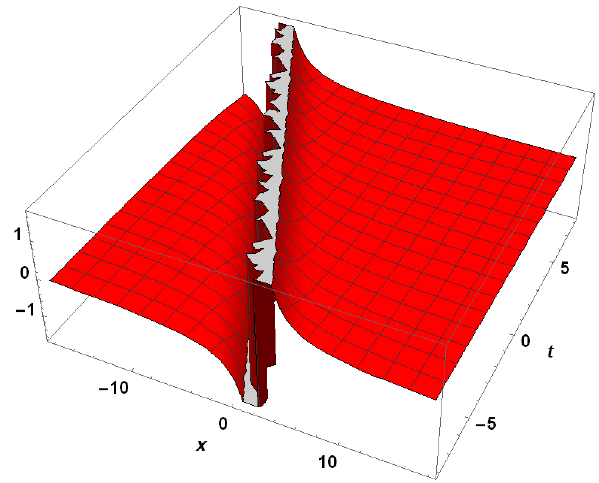
Figure 5. The solitary wave view of the 3D, 2D, and contour plots of U 5 ( x , t ).